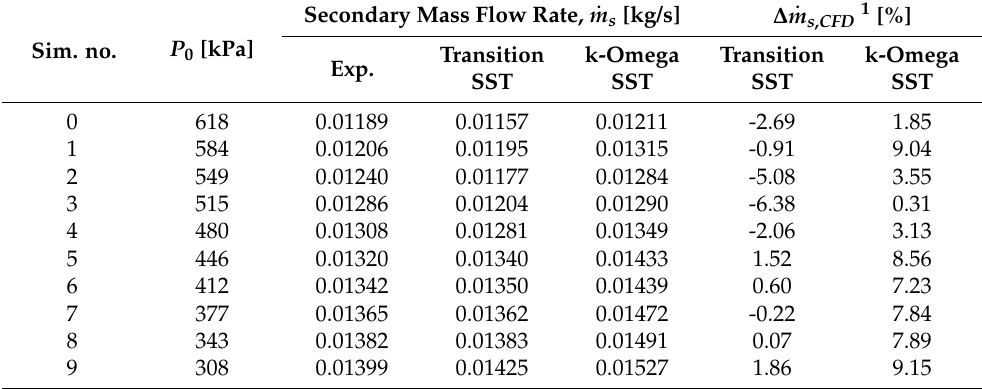
Secondary Mass Flow Rate,